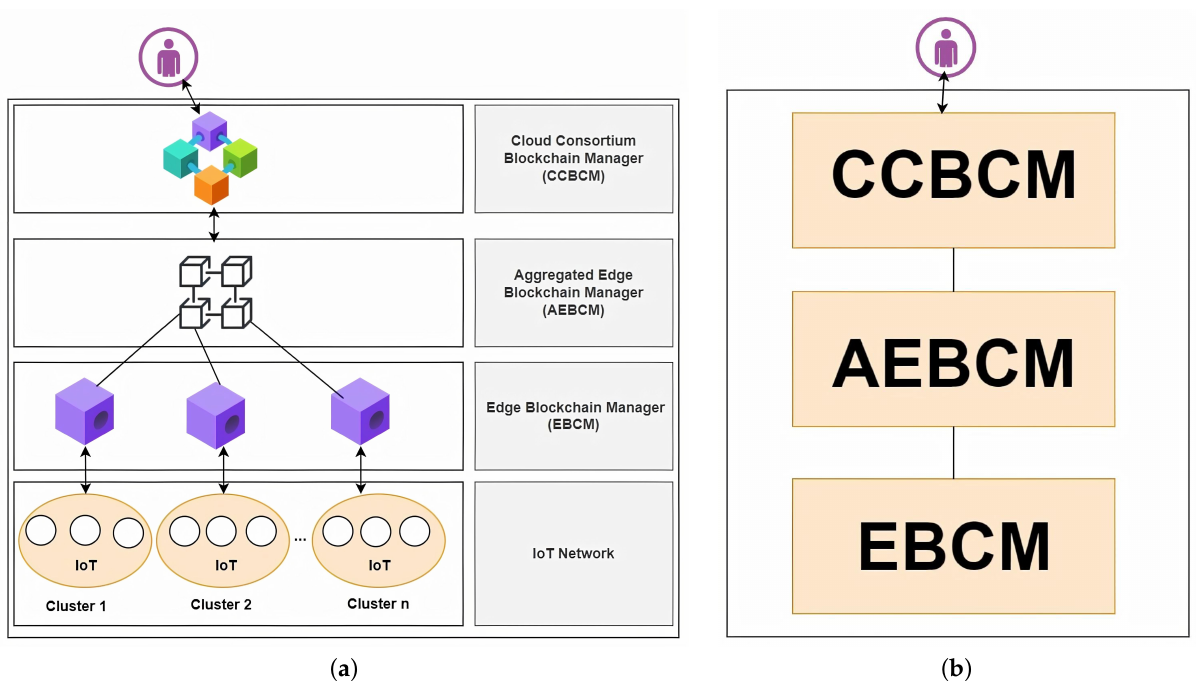
Figure 1. Proposed solution architecture. ( a ) Layered hierarchical BC architecture. ( b ) High-level software